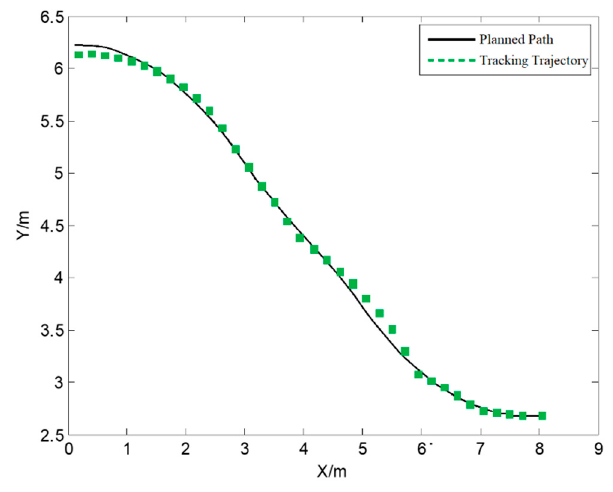
Figure 19. Parking Path Tracking Results of Reference [22].